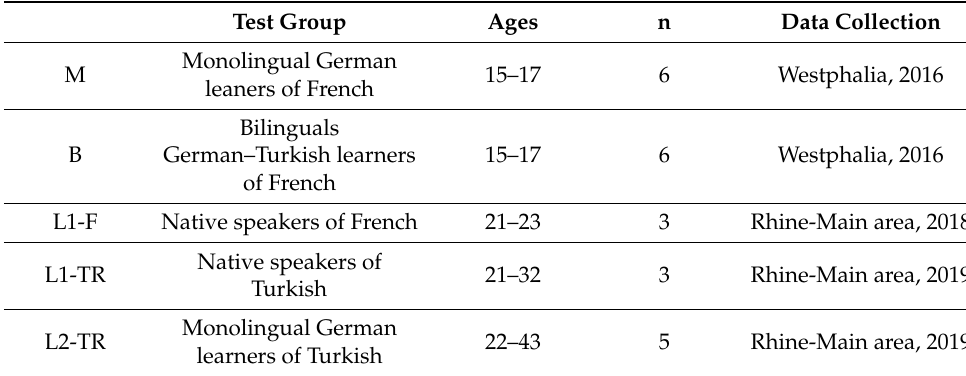
Table 2. Overview of the participant